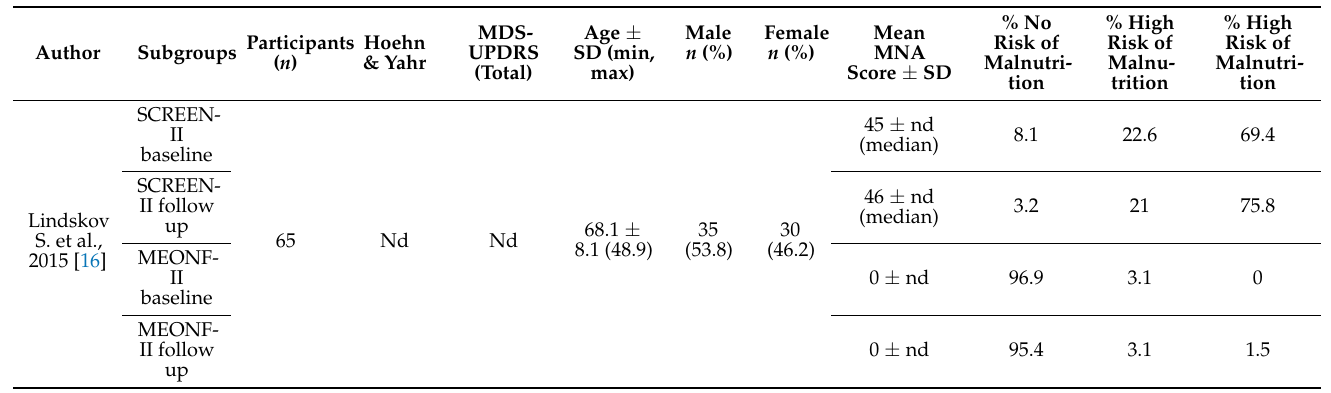
Table 10. Risk of malnutrition in study by Lindskov S. et al., 2015 [16].